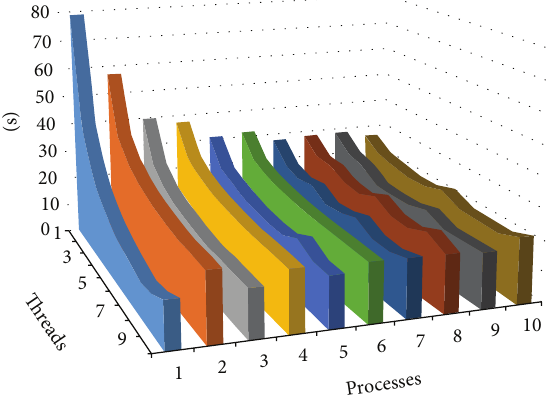
Figure 6: The relation between threads and processes.